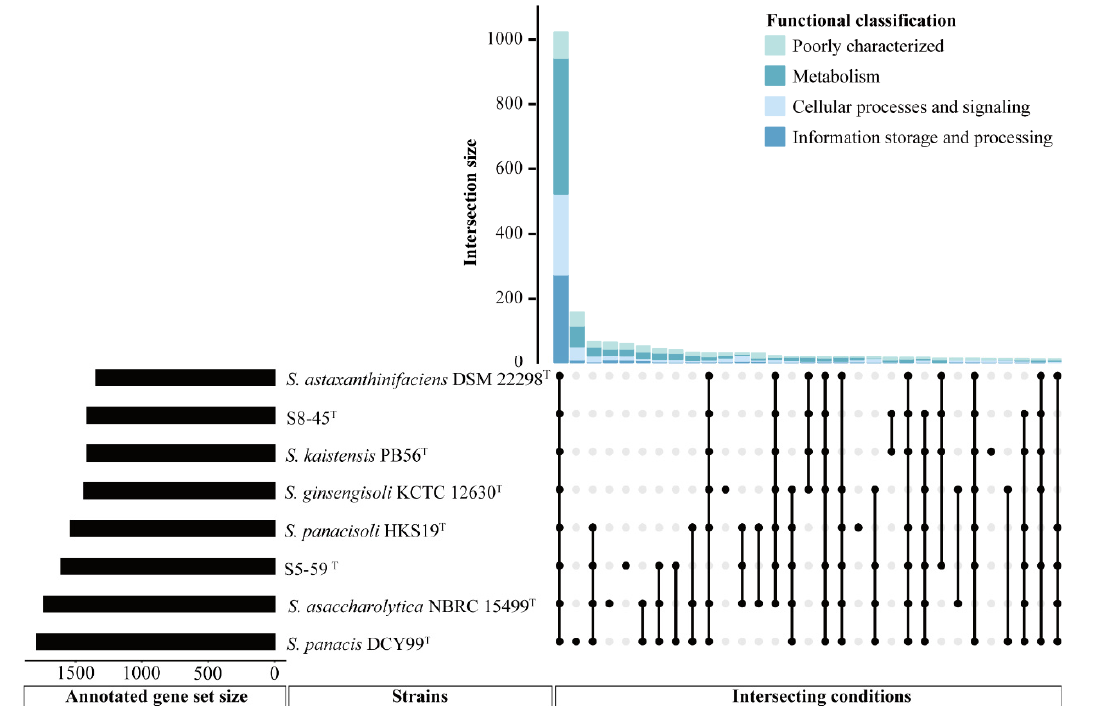
Figure 8. The number and functional gene classification of pan genomes between different Sphingomonas strains. The upset plot shows the number and functional classification of the core and unique genes in different Sphingomonas strains. The bar chart above represents the number of core and unique genes contained in each type of group. The strip at the bottom left represents the total number of genes in different Sphingomonas strains. The dot and line at the bottom right represent the types of different combinations (where only values above 10 and annotated genes are shown; further, unknown genes were not